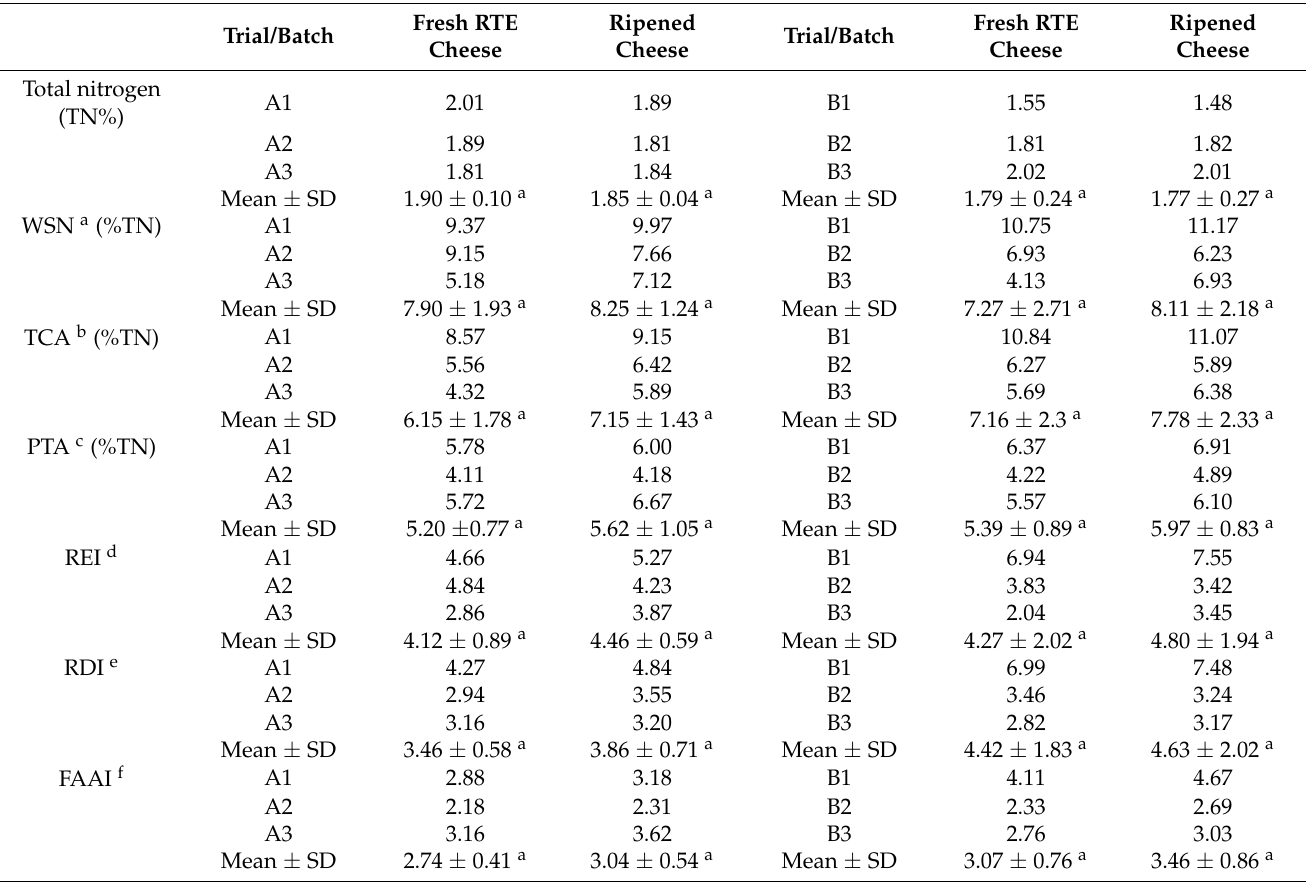
Table 5. Concentration (%) of total nitrogen and nitrogenous fractions of traditional Galotyri PDO cheese fermented with or without supplementation of the basic starter culture with the adjunct strain L. plantarum H25 1